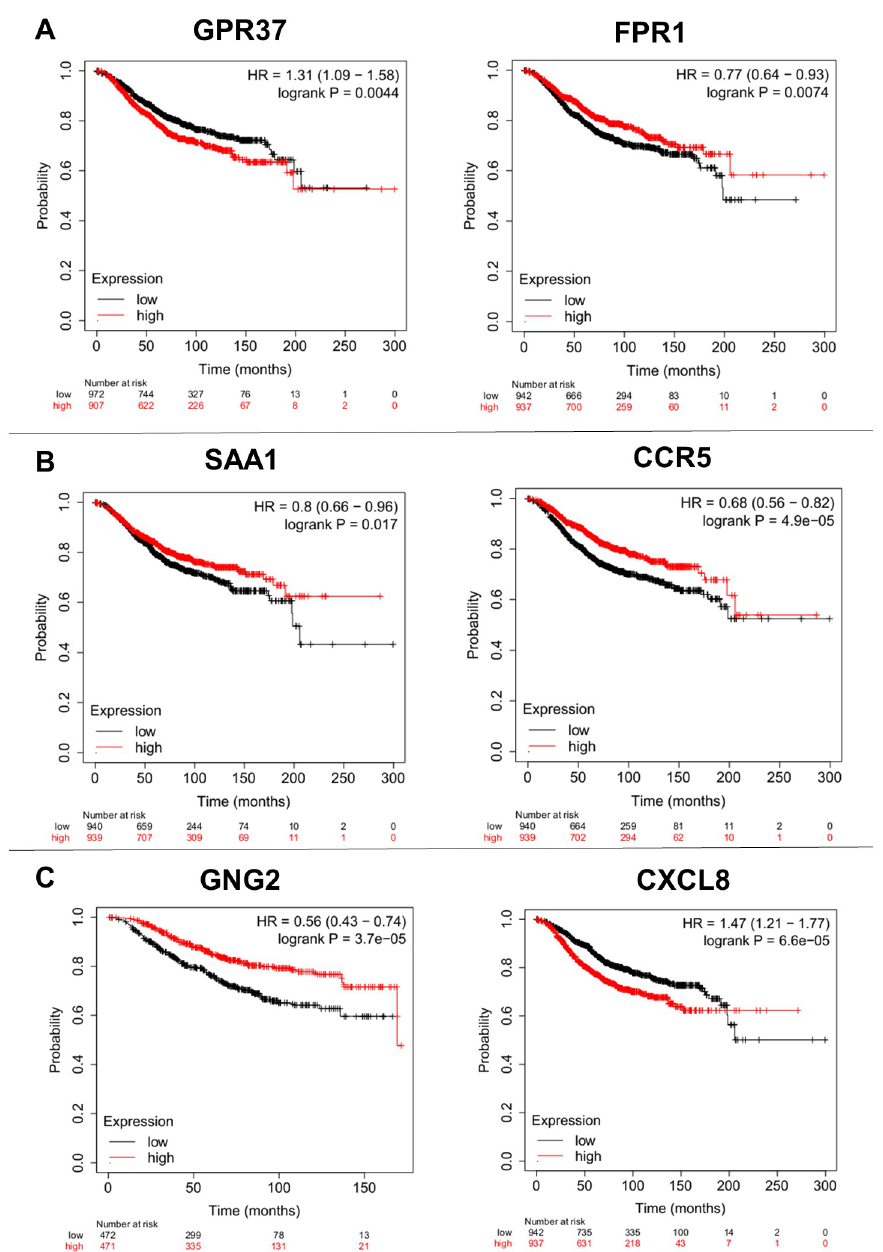
Fig 8. Prognostic values of four specific and two shared hub genes in the brain and lung metastases from breast cancer patients (Kaplan Meier-plotter database). (A) GPR37 and FPR1 which shared between brain and lung metastasis (B) SAA1 and CCR5 were specifically indicated in lung metastasis. (C) GNG2 and CXCL8 were specifically represented among brain metastasis samples. The red line implies the high-expression group and the black line represents the low-expression group. The high- and low-expression cohorts were divided by the median survival time.